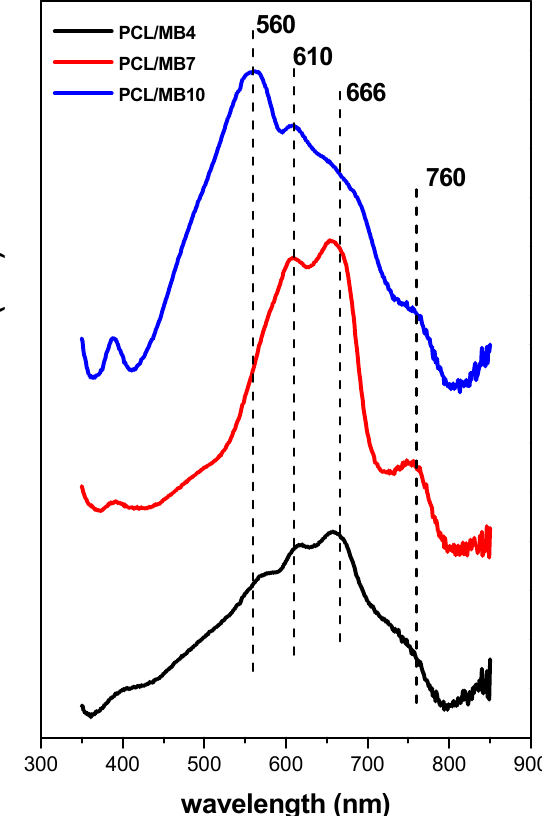
Figure 7. UV-Vis spectra of PCL discs modified with composite films functionalized with methylene blue.